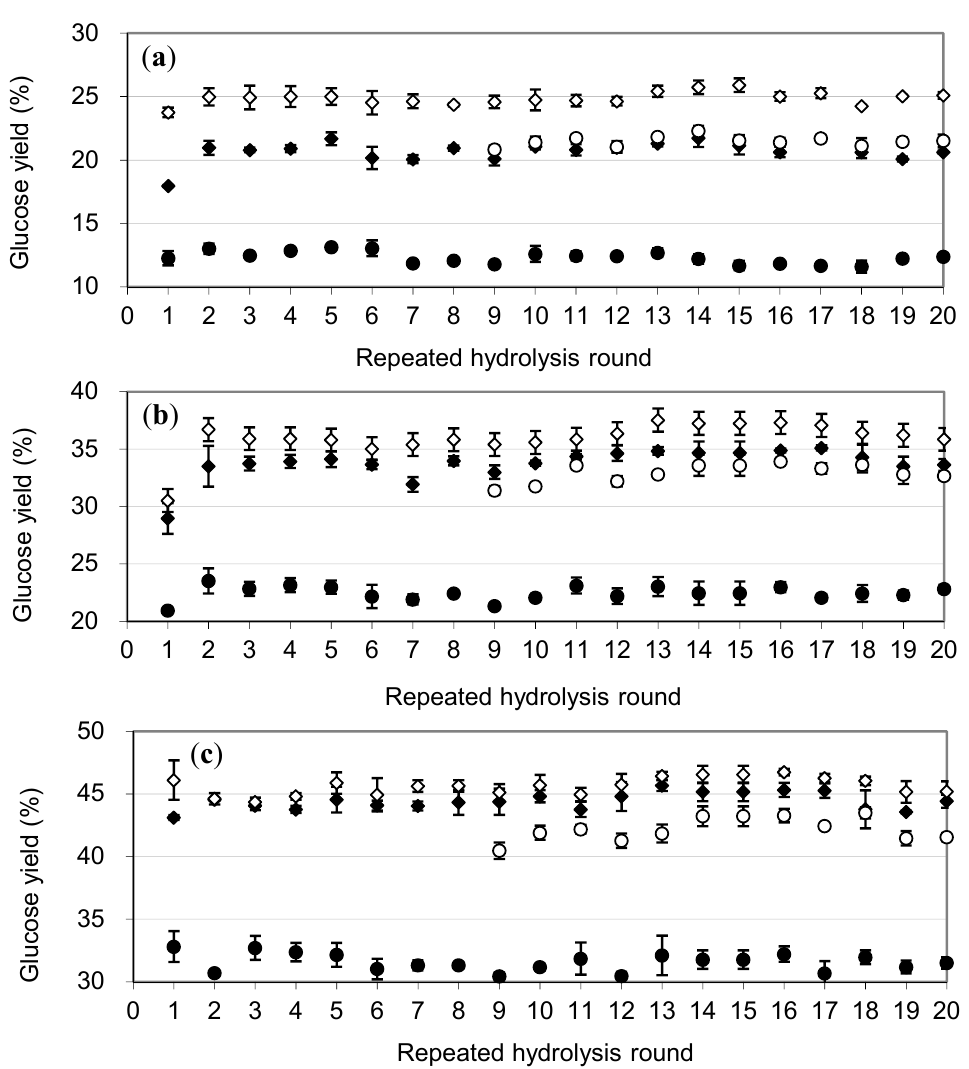
Figure 4. Glucose yields obtained with addition of the immobilized, glutaraldehyde cross-linked BG in calcium alginate beads on Celluclast 1.5 L catalyzed degradation of Avicel after repeated rounds of extended hydrolysis vs. addition of free BG. ( a ), ( b ) and ( c ) are glucose yields at 9, 24 and 48 h. “A” is the IMBG prepared under conditions as in Table 1. ♦ A; ◊ Free BG; ○ ½ Free BG; ● No BG. Data points are shown as averages ±